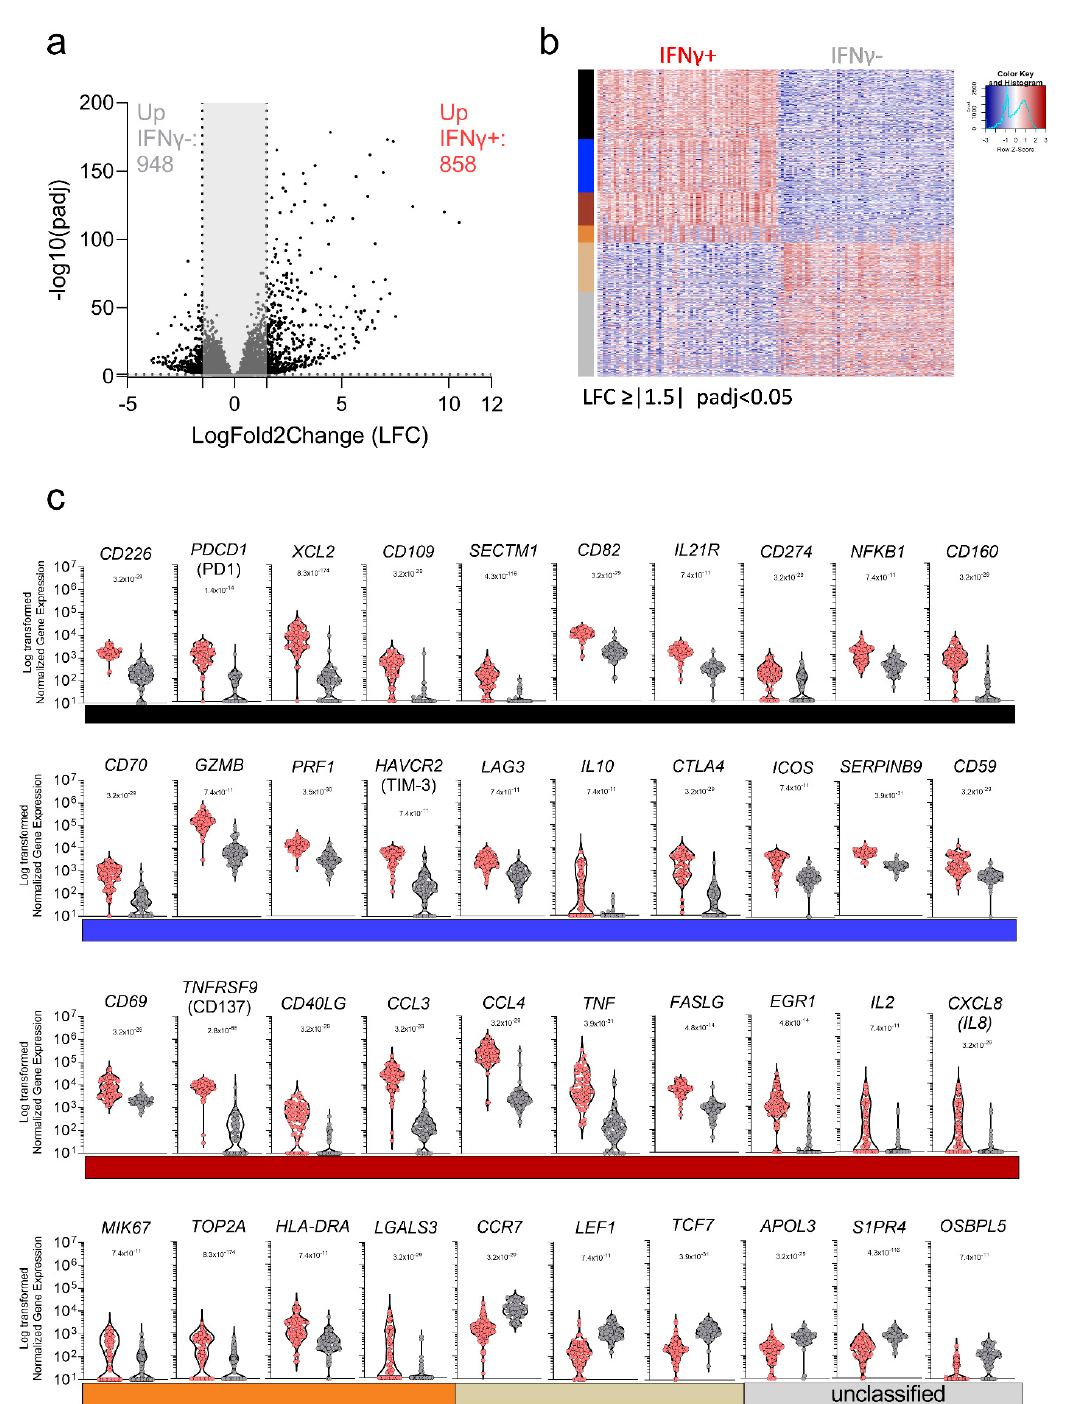
Figure 3. DE genes related to IFN γ signature of DENV-specific CD8+ T cells. ( a ) Volcano plot of differential expressed genes plotted based on their adjusted p -values and log2 fold change gene expression. ( b ) Heatmap of the most significantly differentially expressed genes obtained after comparison of IFN γ − and IFN γ + cells and grouped based on WGCNA analysis. ( c ) Normalized counts of selected genes differentially expressed and related to the WGCNA module/function. All the analyses have been carried out considering significant genes with a log2 fold change gene expression less than − 1.5 and greater than 1.5 and adjusted p -values less than